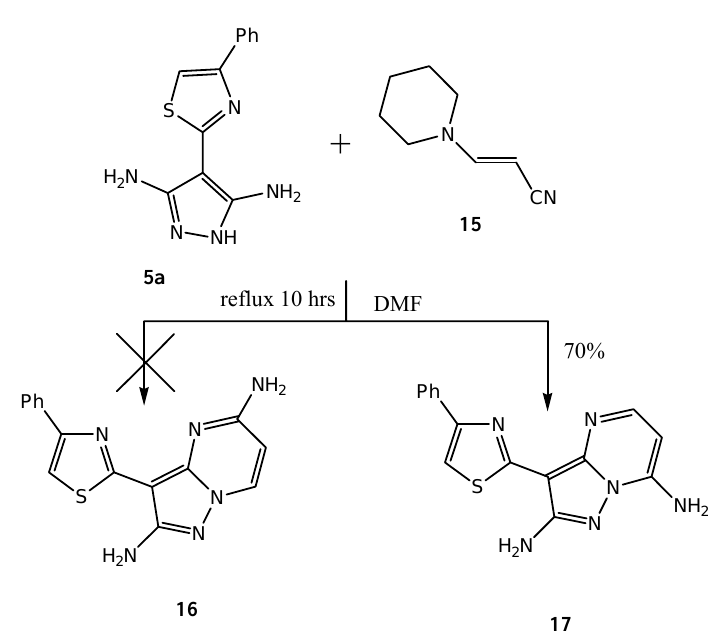
Figure 2. Plot of the x-ray crystallographic data of 3-(4-phenylthiazol-2-yl)pyrazolo[1,5- a]pyrimidine-2,7-diamine ( 17